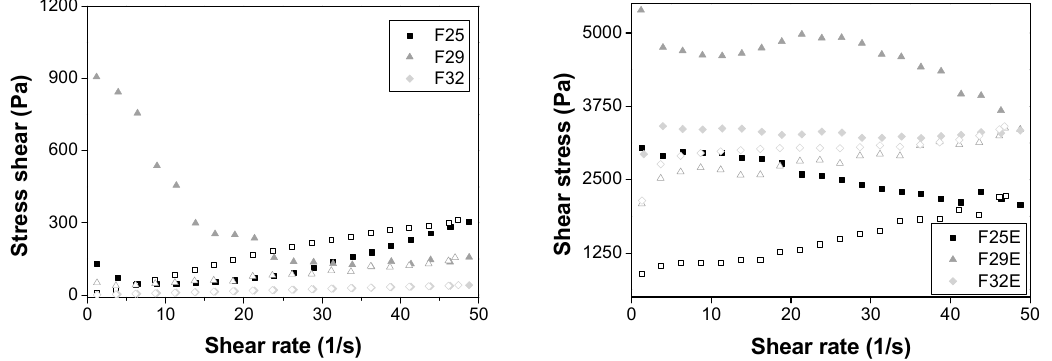
Figure 3. Shear stress versus shear rate of the formulations. Closed symbols represent the up curve and open symbols represent the down curve. Standard deviations have been omitted for clarity; however, in all cases, the coefficient of variation of triplicate analyses was less than 10%. Data were collected at 32.0 ± 0.5 °C.